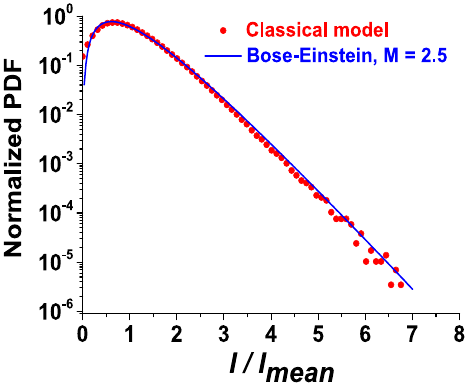
Figure 1. Normalized simulated PDFs of a polarized ASE source. Blue line: PDF simulated with Bose–Einstein theory for M = 2.5. Red dots: PDF simulated with the enhanced classical